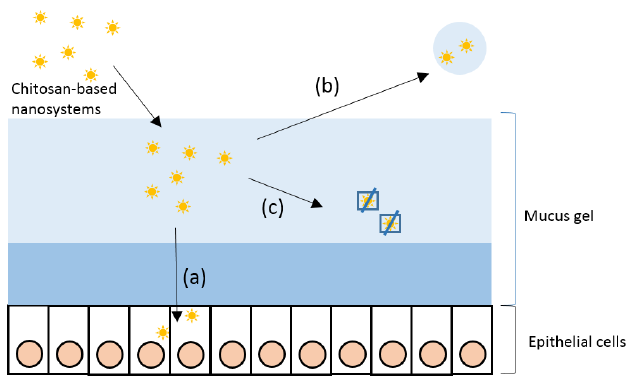
Figure 5. Possible scenarios in the interaction of chitosan-based nanosystems and mucins. Once the nanosystems achieve the mucus, they can go through the mucus and reach the epithelium ( a ), be shed with the mucus ( b ) or get trapped in the mucus gel ( c ).